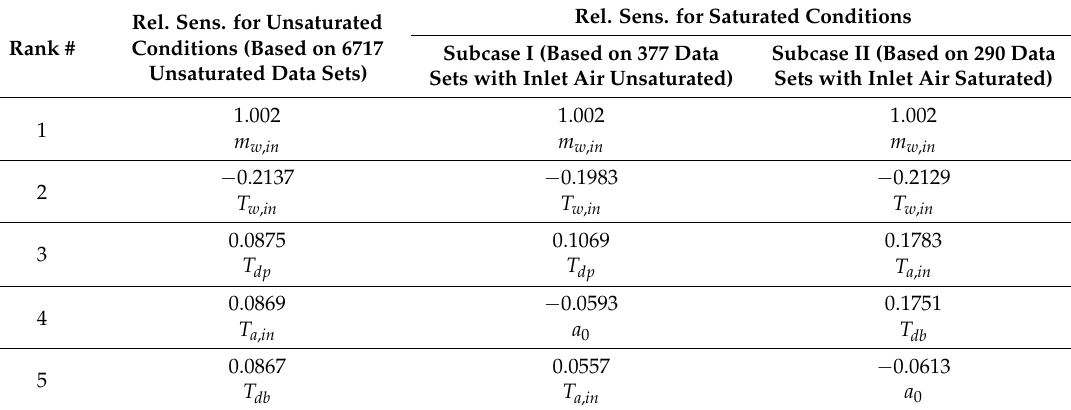
Table 9. Cross-comparison of the top five relative sensitivities for the response of water outlet mass ( 50 ) flow rate, m w .